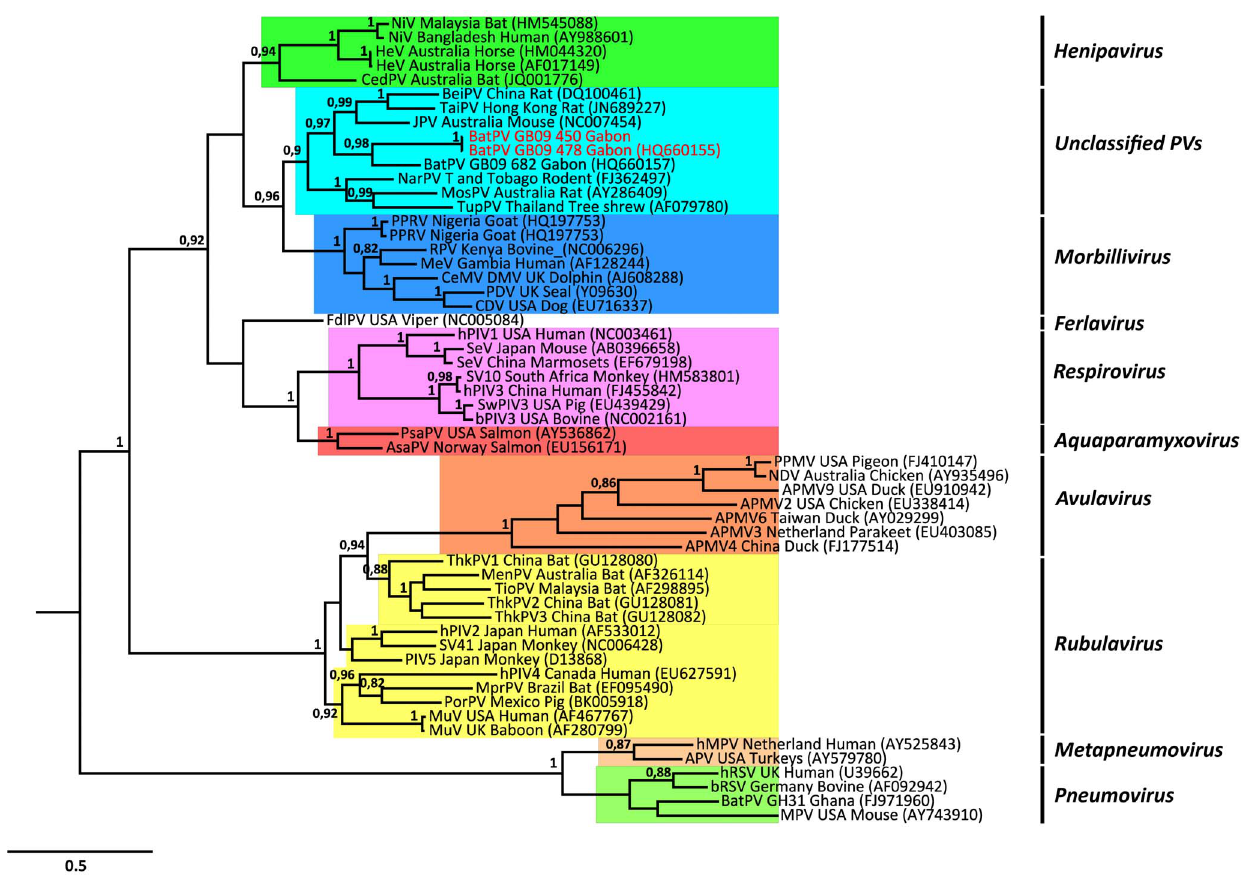
Fig. 1. Phylogenetic tree based on a 439-basepair fragment of the polymerase gene (L) of members of the Paramyxoviridae family. Sequences generated in this study are highlighted in red. Bayesian posterior probabilities are shown; values , 0.80 were removed for clarity. The viruses are designated as follows (virus abbreviation/typical host/accession numbers of reference sequences in brackets): HeV 5 Hendra virus, NiV 5 Nipah virus, BatPV 5 Bat paramyxovirus, BeiPV 5 Beilong virus, JPV 5 J virus, MosPV 5 Mossman virus, TupPV 5 Tupaia paramyxovirus, NarPV 5 Nariva virus, PDV 5